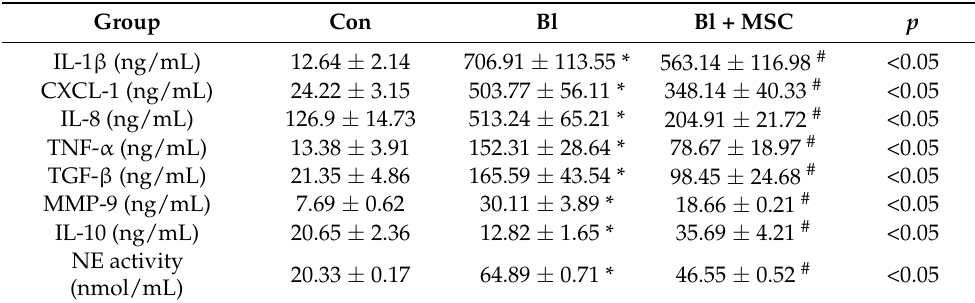
Table 3. Levels of inflammatory factors in